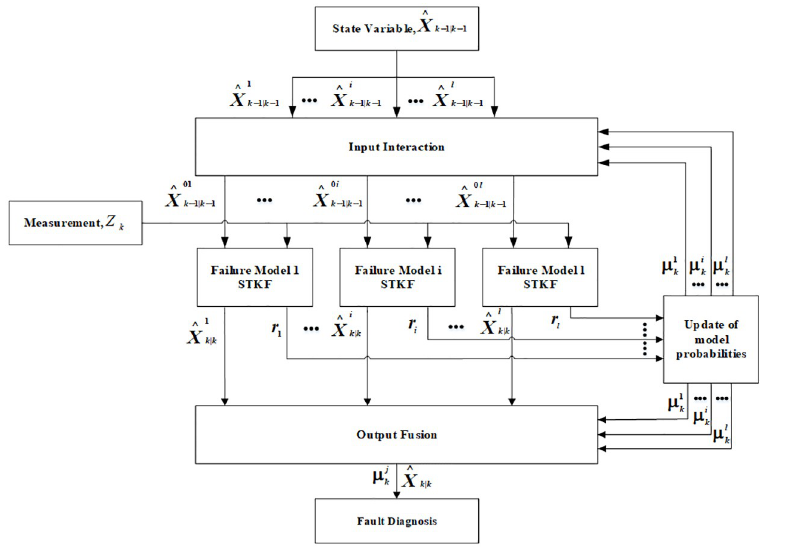
Fig 5. IMM algorithm flow